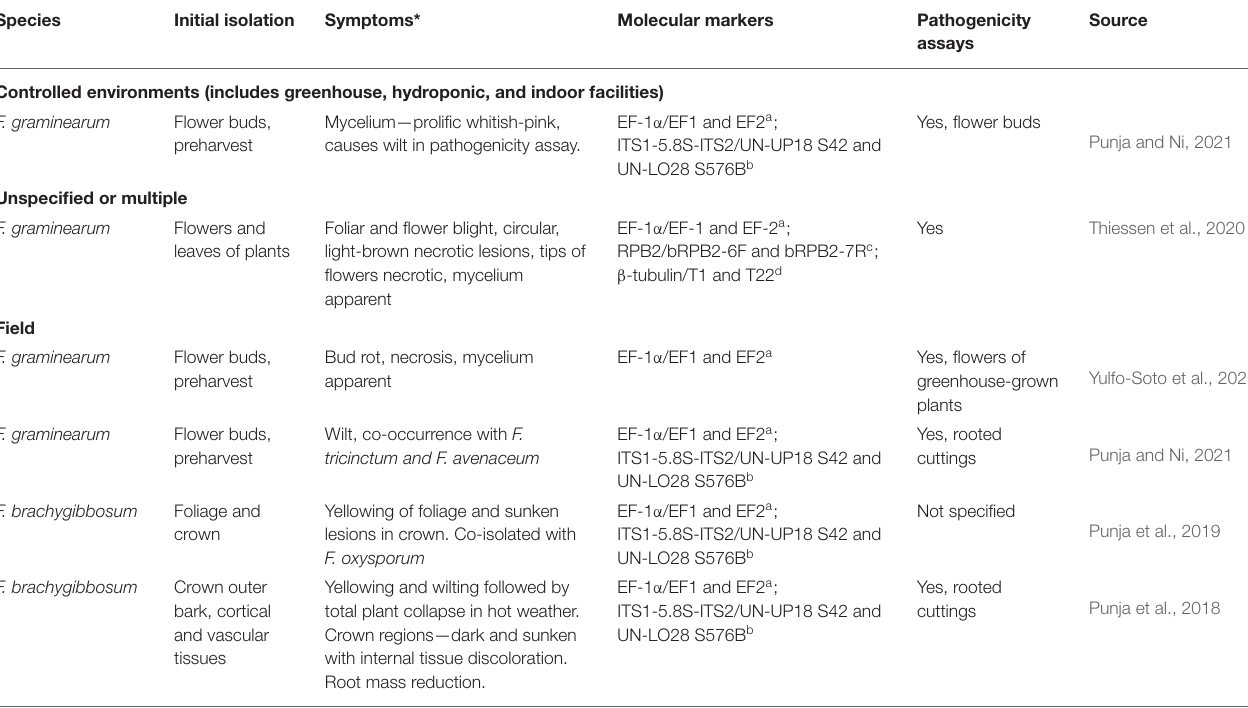
TABLE 5 | Diseases reported in C. sativa caused by members of the Fusarium sambucinum species complex.